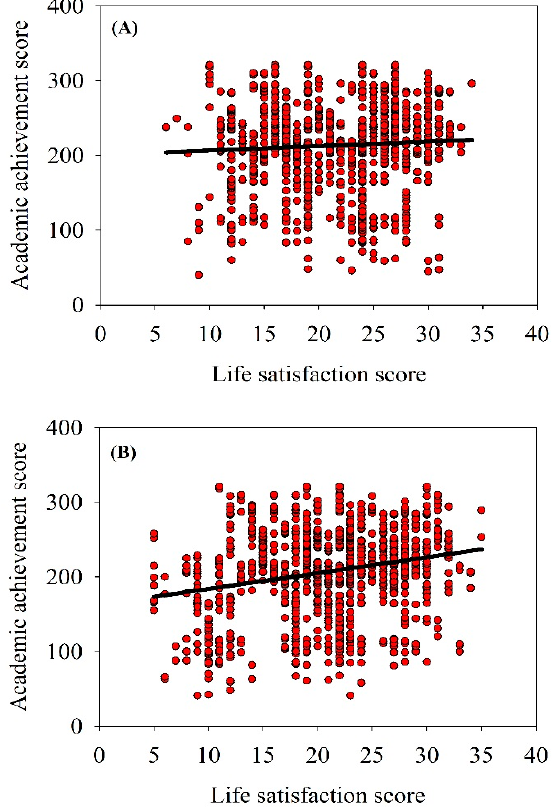
Figure 1. The relationship between life satisfaction and academic achievement of ( A ) non-left-behind children and ( B ) left-behind children (LBC) in rural China ( n = 2031).